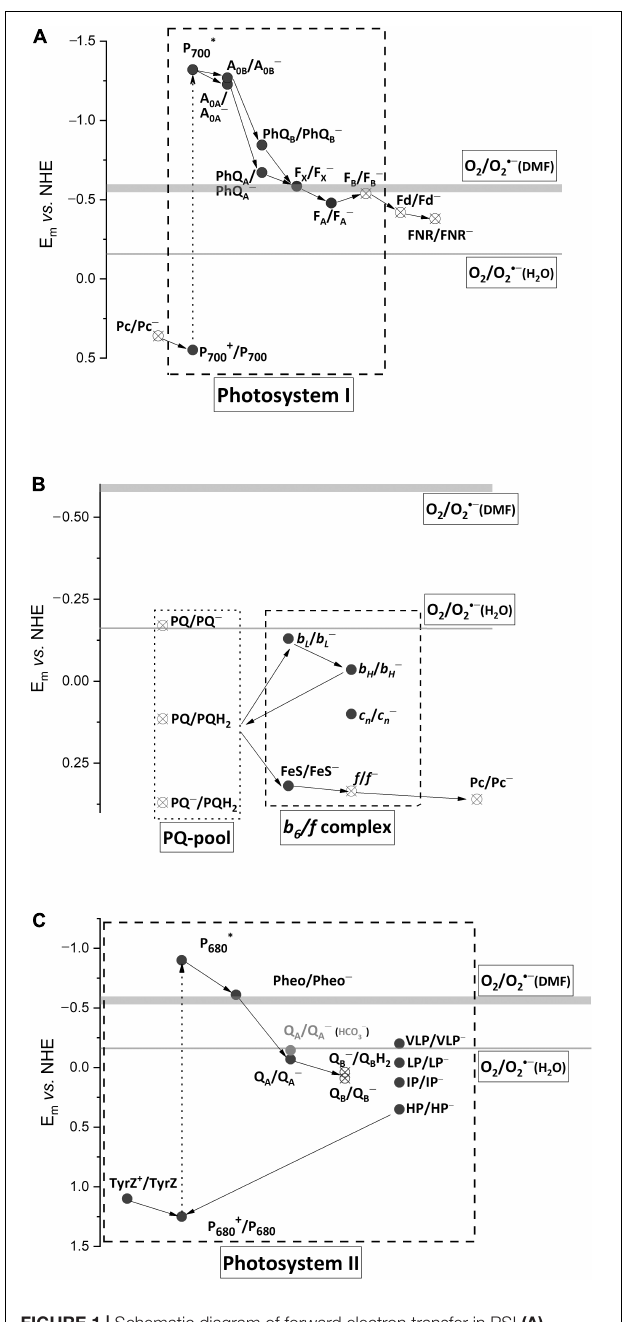
FIGURE 1 | Schematic diagram of forward electron transfer in PSI (A) , PQ-pool and cytochrome b 6 /f complex (B) , and PSII (C) , with E m values of the cofactors. The E m values of (O 2 /O 2 •− ) in water, –160 mV, and dimethylformamide (DMF), from –550 to –600 mV, are shown by thin and thick horizontal lines, respectively. Pc, plastocyanin; P 700 , the dimer of Chl a molecules in PSI; A 0 , the primary electron acceptor in PSI; PhQ, phylloquinone, a secondary electron acceptor in PSI; F X , a 4Fe–4S cluster, a secondary electron acceptor in PSI; F A and F B , 4Fe–4S clusters, the terminal electron acceptors in PSI; Fd, ferredoxin, the mobile electron acceptor; FNR, ferredoxin/NADP + reductase; PQ, PQ •− , and PQH 2 , plastoquinone, plastosemiquinone, and plastoquinol; FeS, a 2Fe-2S cluster of Rieske protein; f , cytochrome f; b L and b H , the low- and high-potential forms of